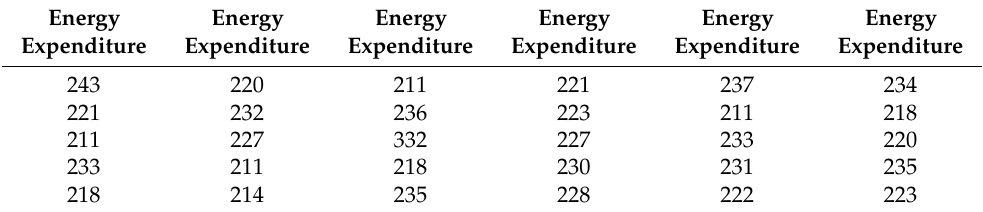
Table 10. Results of the ant colony algorithm [kWh].